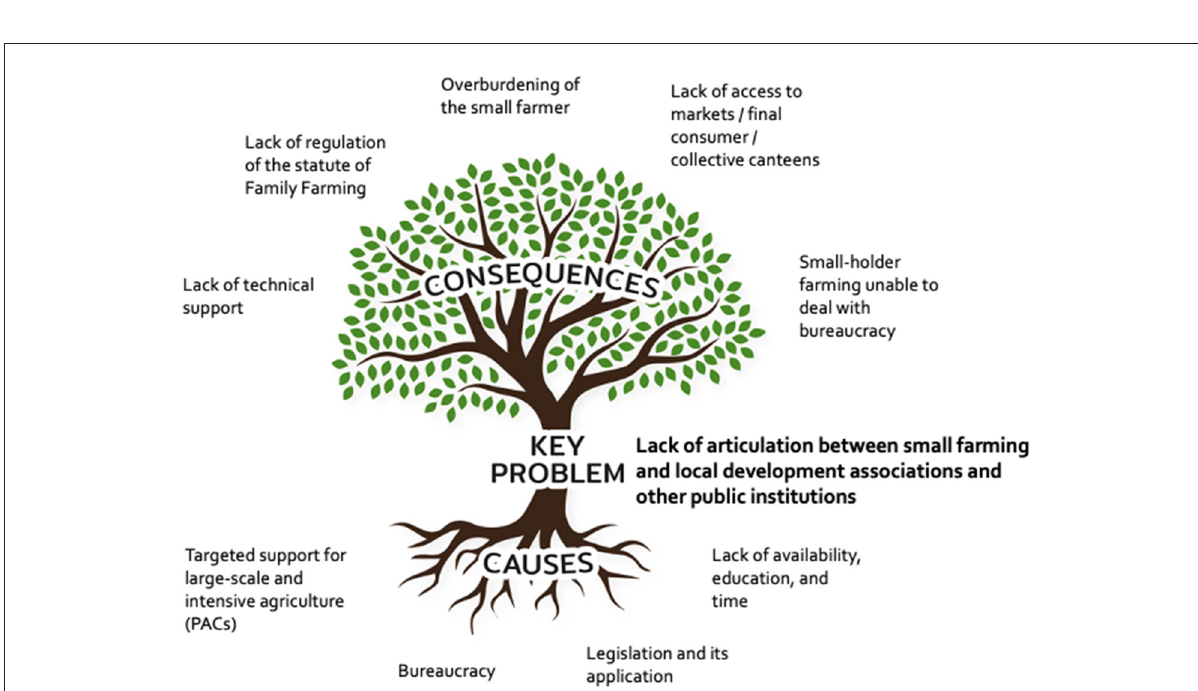
FIGURE5 Problem tree 2—Lack of articulation between small farming and support